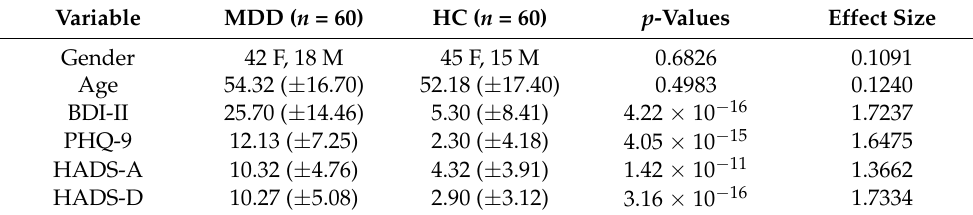
Table 3. Demographic data and scores of questionnaires for participants in the test